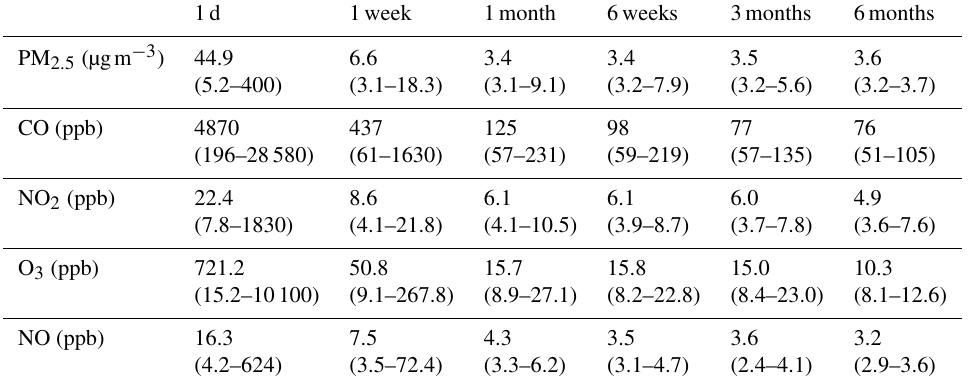
Table 1. The median and range (1st–99th percentile) of the RMSE from 250 calibration runs from six co-location lengths (1d, 1 week, 6 weeks, 1 month, 3 months, and 6 months) for five low-cost sensors. The median and range (min to max) of PM 2 . 5 , CO, NO 2 , O 3 , and